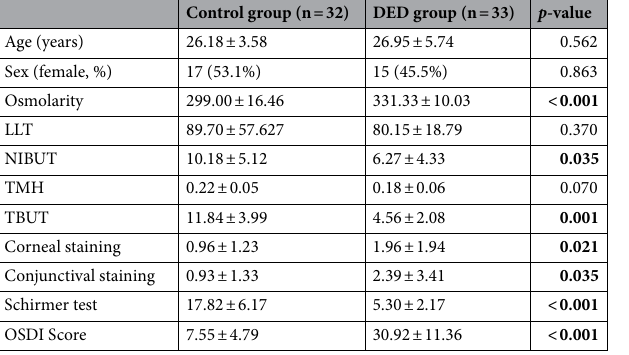
Table 1. Baseline characteristics and dry eye parameters in the control and DED groups. Bold values indicate statistical significance ( p < 0.05). LLT, lipid layer thickness; NIBUT, non-invasive tear break-up time; TMH, tear meniscus height; TBUT, tear break-up time; OSDI, ocular surface disease